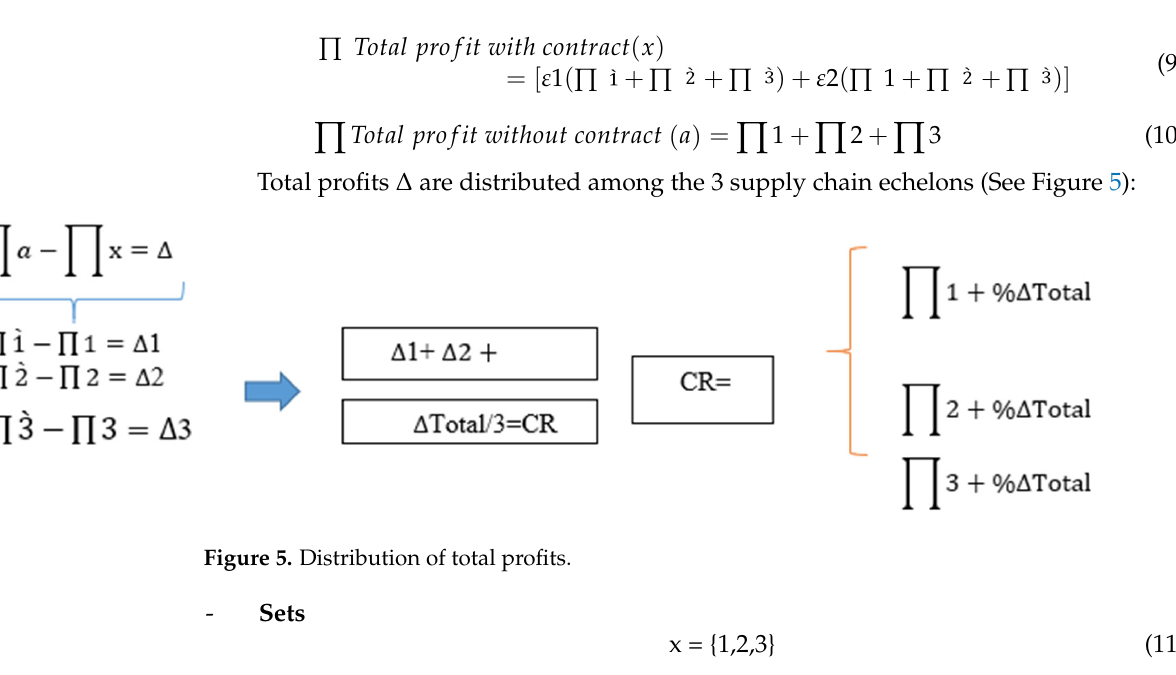
Table 4. Parameters Contract model